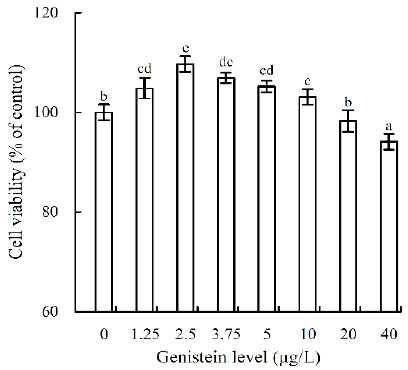
Figure 1. Cell viability of osteoblasts treated with genistein at 0–40 μ g/L for 48 h. The values are presented as means ± standard deviations ( n = 3). Different letters indicate significantly different values ( p < 0.05) using one-way ANOVA analysis.